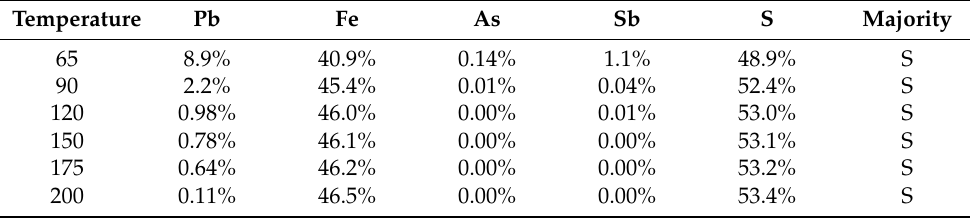
Table 14. Results for initial kinetics model with second set of minerals in weight percentage. Temperature Pb Fe